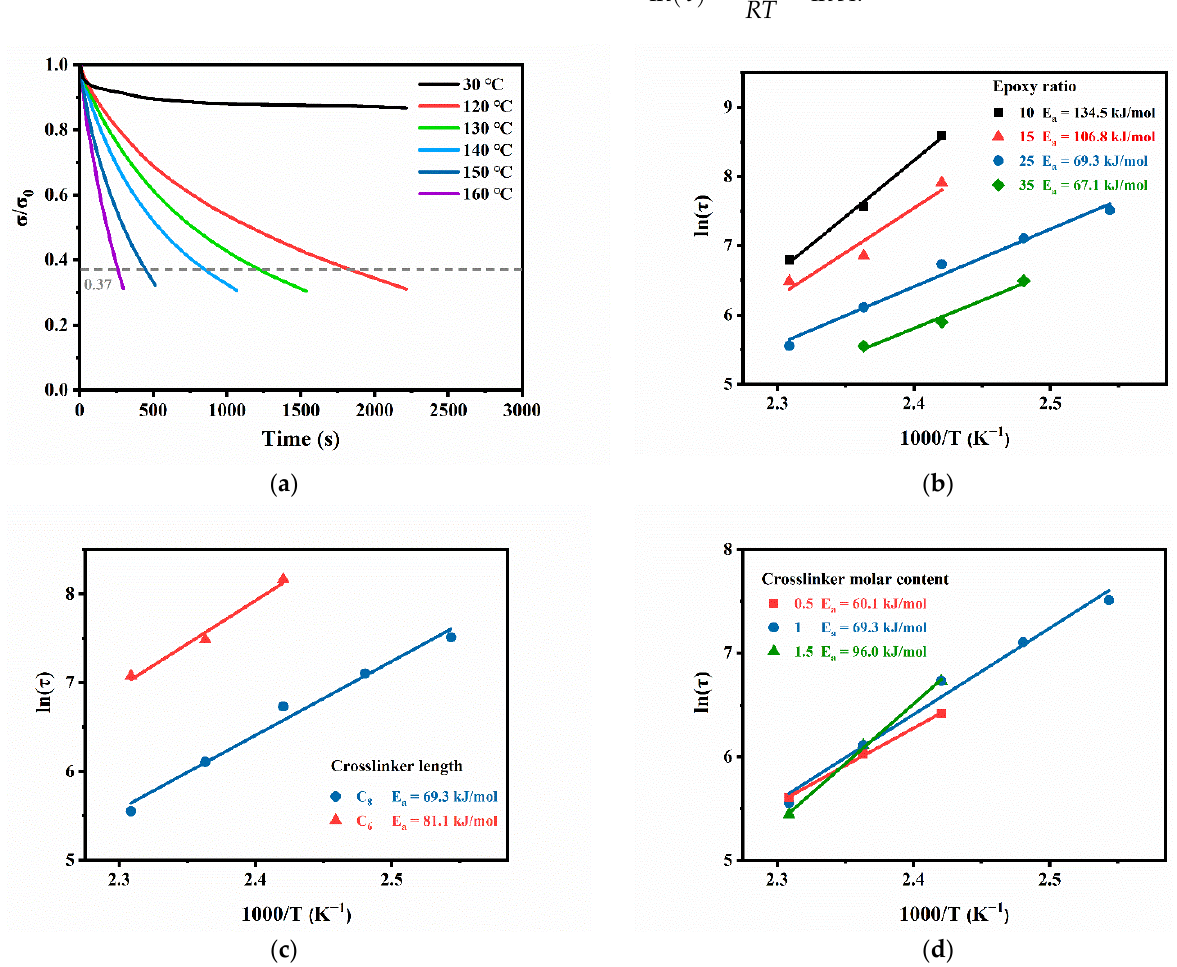
Figure 4. ( a ) Stress relaxation curves of vitrimer 4; linear fitting of the relaxation times by Arrhenius equation for EPB vitrimers with the modification of network parameters: ( b ) epoxy ratio, ( c ) crosslinker length, and ( d ) crosslinker molar content.